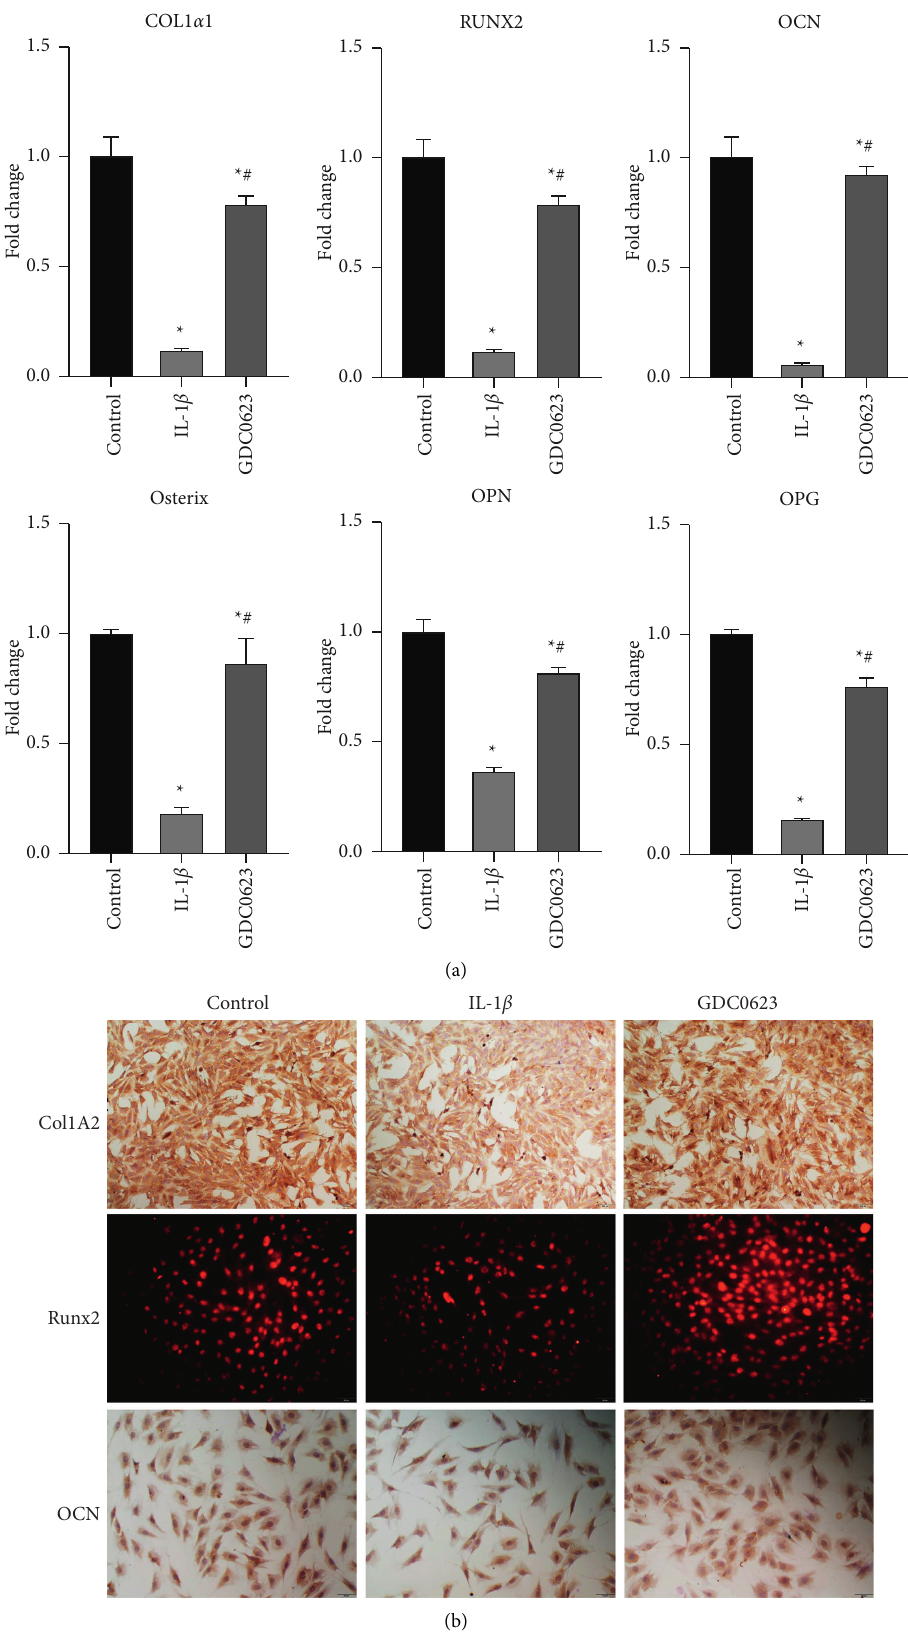
Figure 4: Osteoblastic gene expression profiles in osteoblasts after treatment with GDC0623. (a) Osteoblasts were maintained in an osteogenic differentiation medium containing IL-1 β or IL-1 β plus GDC0623 for 7 days. qPCR analysis of osteogenic gene expression in osteoblasts was performed, relative to internal control GAPDH and normalized to control cells. (b) Immunocytochemical staining of Runx2, OCN, and Col I in osteoblasts after treatment with IL-1 β or GDC0623 plus IL-1 β for 7 days. Data are expressed as mean ± SD for n � 3. ∗ p < 0.05 versus the control group, # p < 0.05 versus the IL-1 β